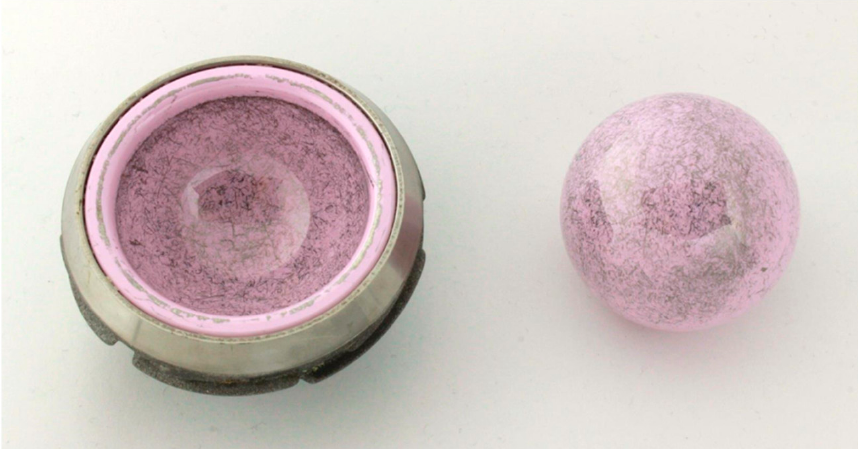
Figure 5. Ceramic-on-ceramic bearing couple with globally distributed metallic deposition on femoral head and insert.